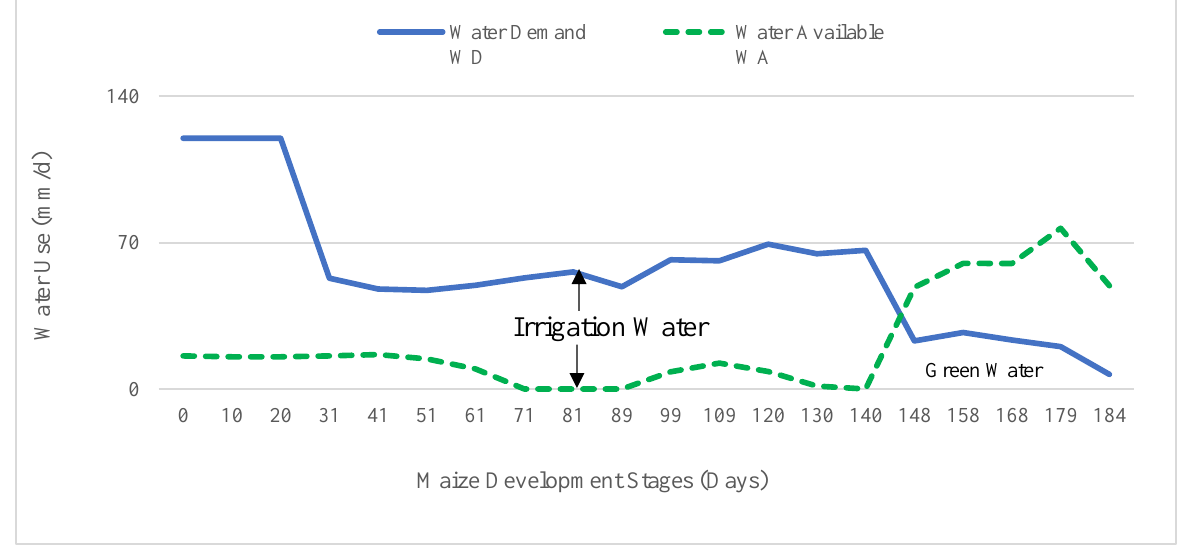
Figure A4. Graphical representation of water demand and water available for maize .